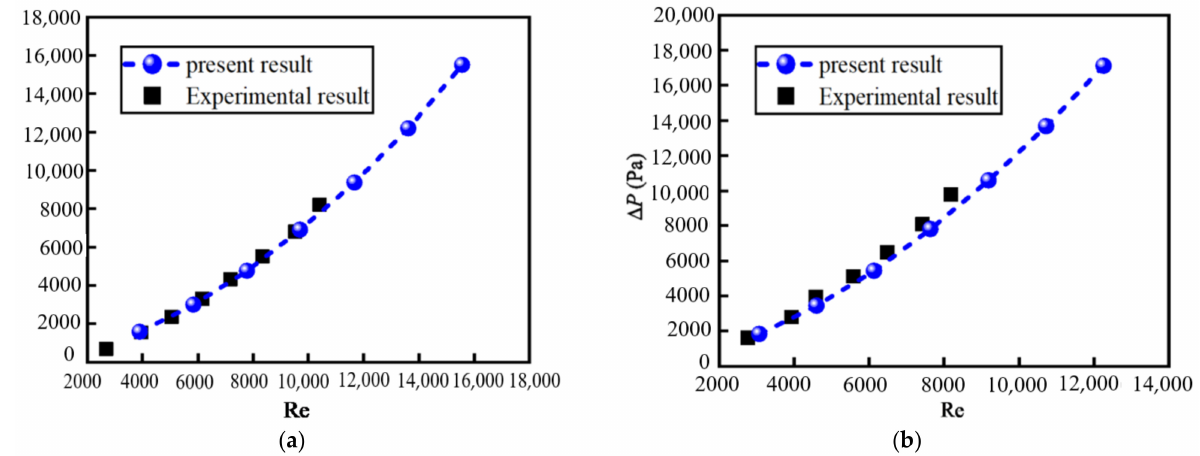
Figure 4. Relationship between ∆ P and Re with different ϕ : ( a ) ϕ = 0.005; ( b ) ϕ = 0.04.